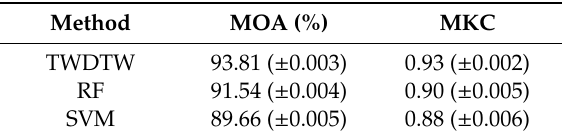
Table 2. Mean overall accuracy (MOA) and mean kappa coe ffi cient (MKC) of TWDTW, RF, and SVM applied to the test